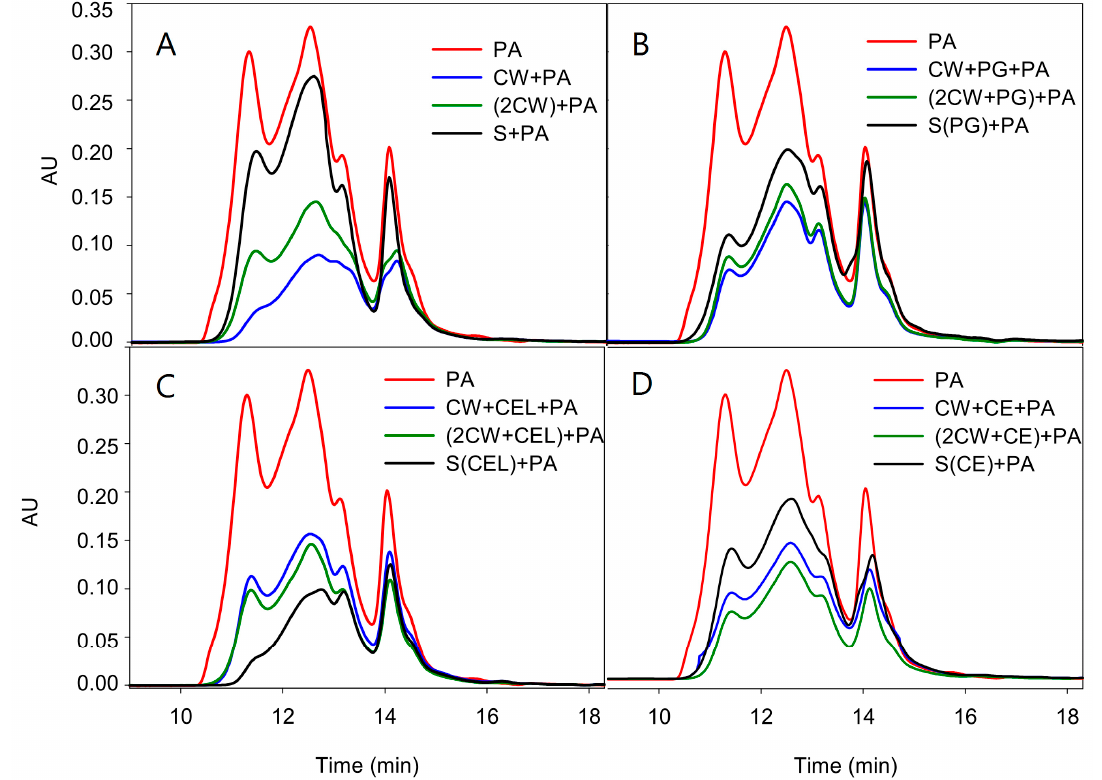
Figure 1. Comparison of the size exclusion chromatogram of the original proanthocyanidin in solution and that for those remaining after ( A ) the first (CW + PA) or second experiment (2CW + PA) as well as those remaining after reacting with the polysaccharides found in the model solution (S + PA); ( B ) the first (W + PG + PA) or second experiment ((2CW + PG) + PA) when polygalacturonase was present, as well as those remaining after reacting with the polysaccharides found in the model solution (S(PG) + PA); ( C ) the first (CW + CEL + PA) or second experiment ((2CW + CEL) + PA) when cellulase was present, as well as those remaining after reacting with the polysaccharides found in the model solution (S(CEL) + PA); and ( D ) the first (CW + CE + PA) or second experiment ((2CW + CE) + PA)